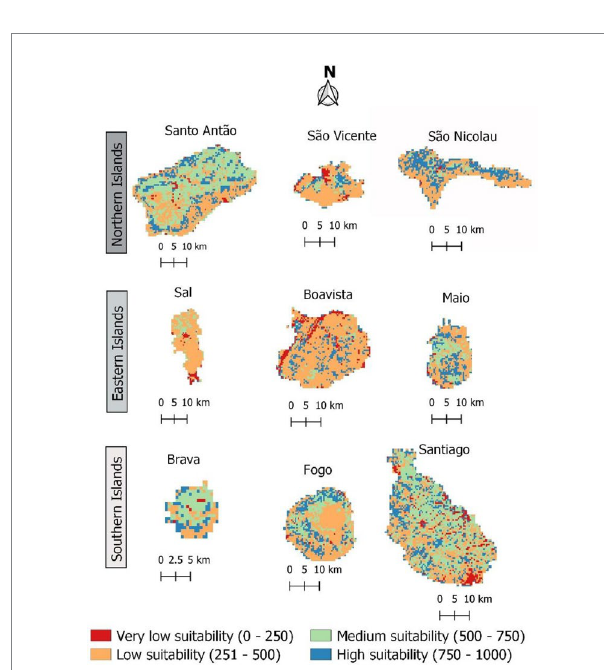
FIGURE 9 Change in habitat suitability for Faidherbia albida in Cabo Verde, by 2080 under RCP 4.5. Loss indicates areas where habitat suitability is expected to decline. Gain shows areas where habitat suitability is expected to